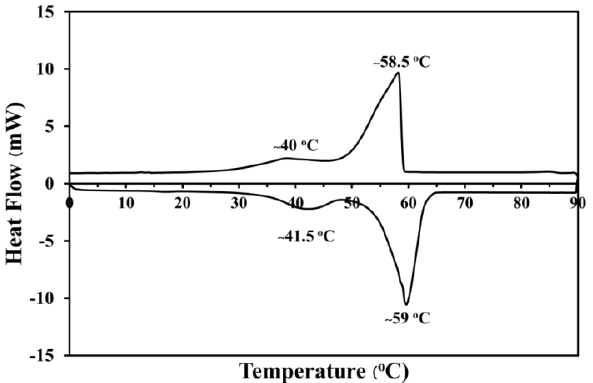
Figure 4. DSC plots showing the melting point of PCM.